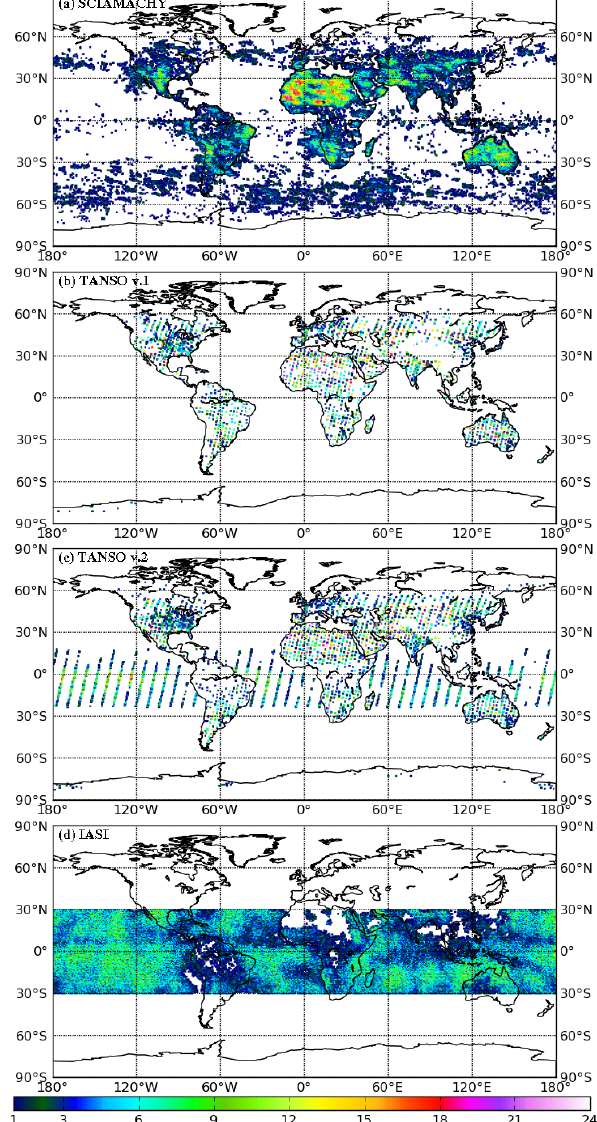
Figure 2. Number of assimilated observations in October 2011, for Fig. 2. Number of assimilated observations in October 2011, for (a) SCIAMACHY, (b) TANSO v.1 and (c) TANSO v.2.0, and (d) IASI. The (a) SCIAMACHY, (b) TANSO v.1, (c) TANSO v.2.0, and (d) IASI. observations are gridded on a 0 . 7 ◦ × 0 . 7 ◦ grid. The observations are gridded on a 0 . 7 ◦ × 0 . 7 ◦ grid.